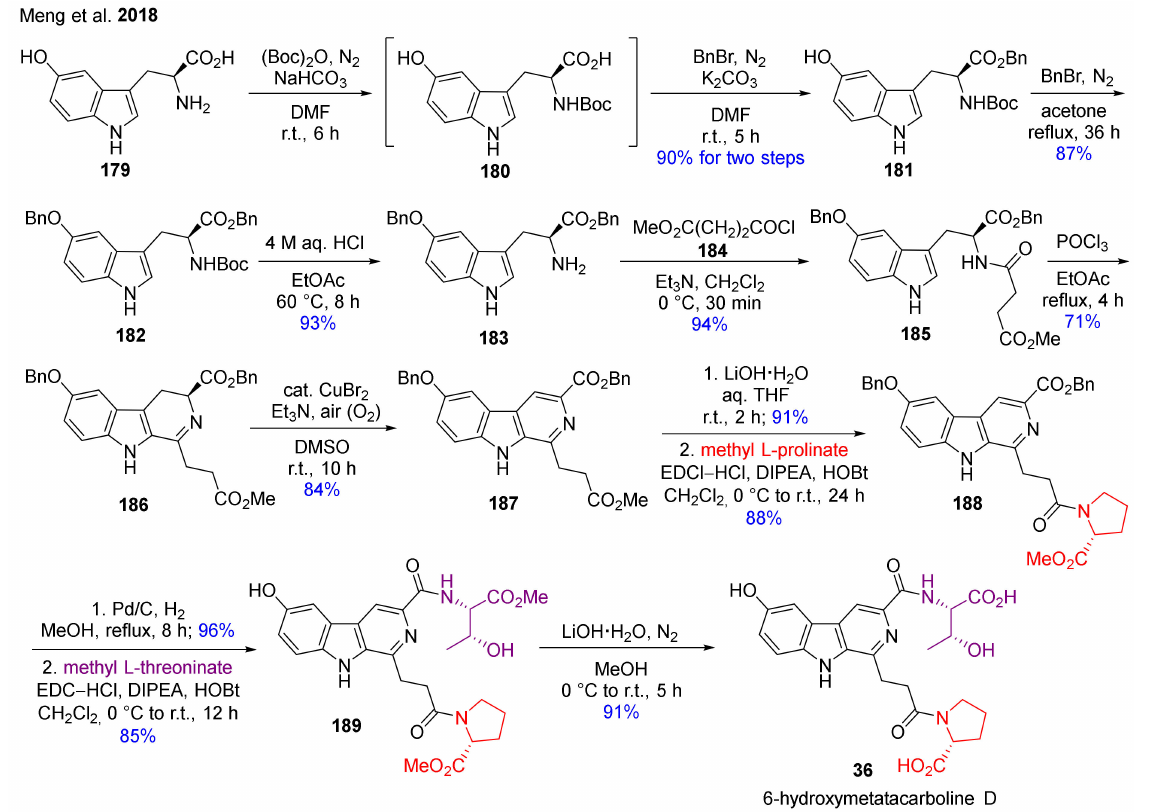
Scheme 17. Synthesis of 6-hydroxymetatacarboline D ( 36